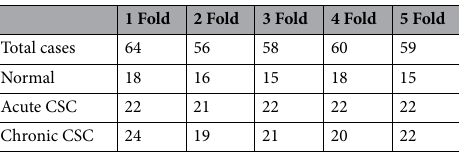
Table 4. Description of the fivefold cross-validation split. CSC central serous